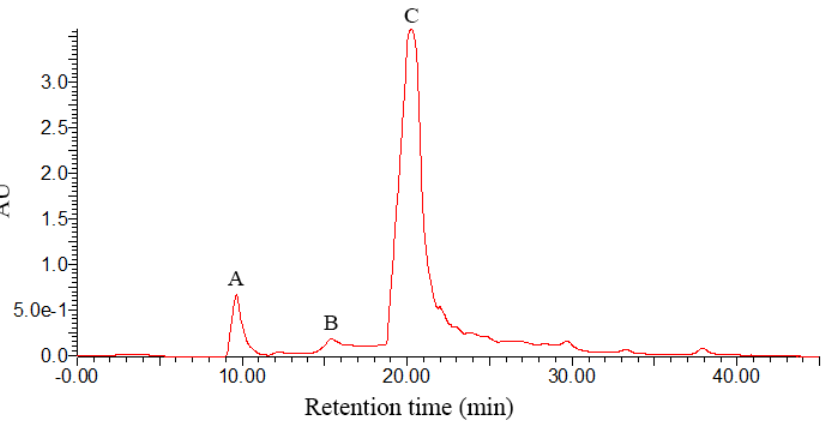
Figure 1. Prep-HPLC diagram of butyryl-DHM: ( A ) DHM; ( B ) product 1; ( C ) product 2.